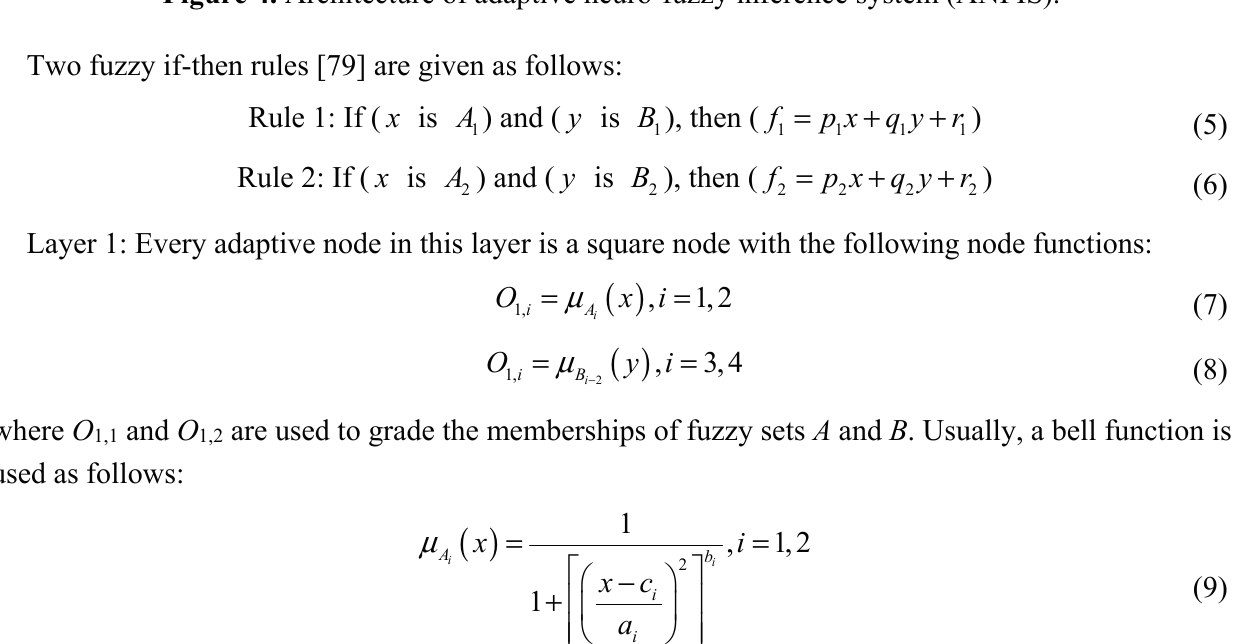
Figure 4. Architecture of adaptive neuro-fuzzy inference system